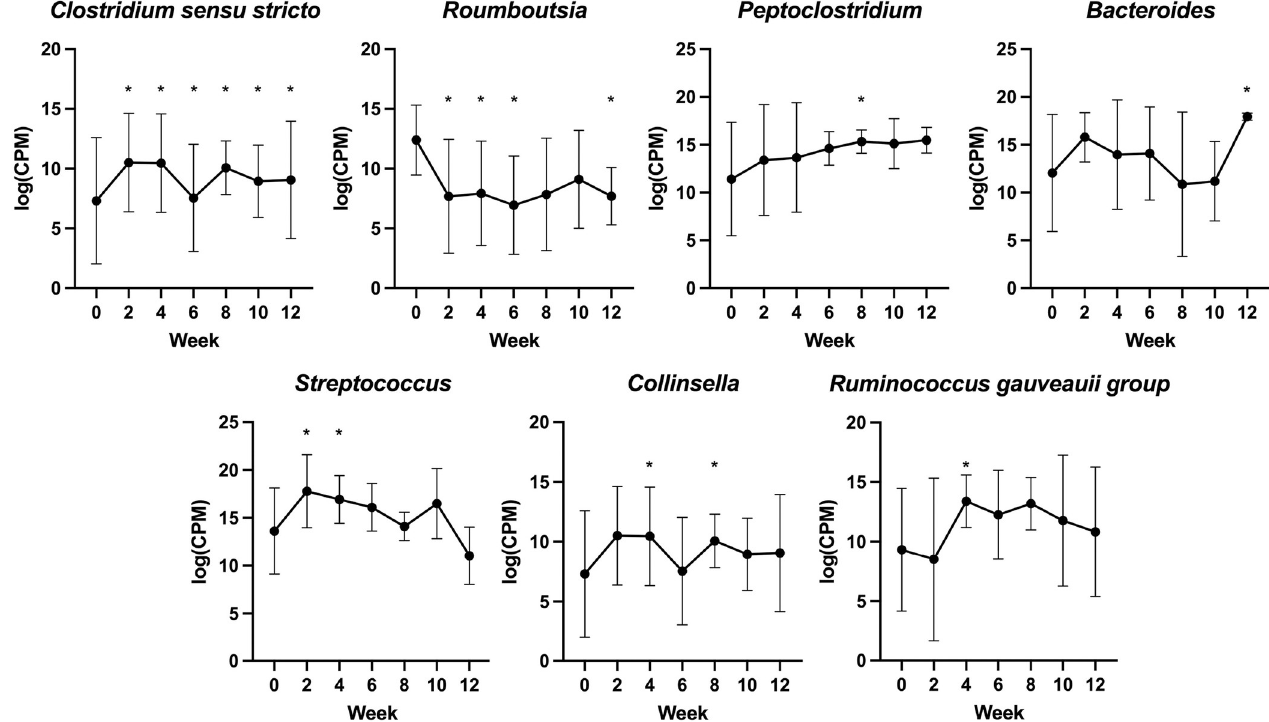
Fig 5. Changes in relative abundances of ASVs with significant associations with time. � indicates relative abundance significantly different from week